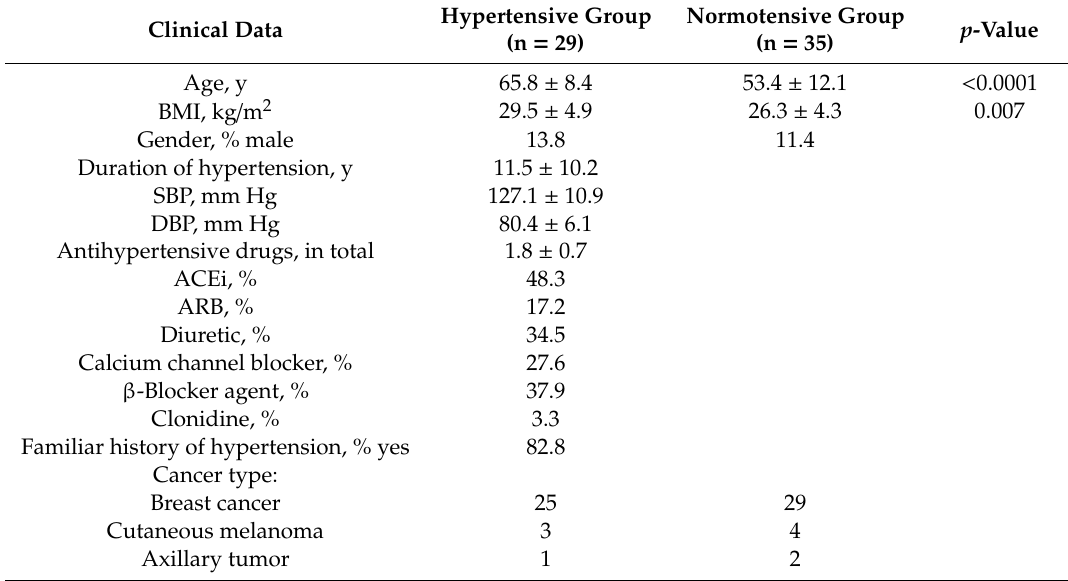
Table 1. Demographic and medical data on hypertensive vs. normotensive